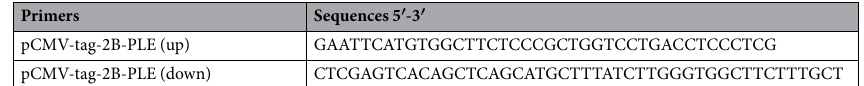
Table 2. The primers for sub-cloning cDNA of PLE1 and